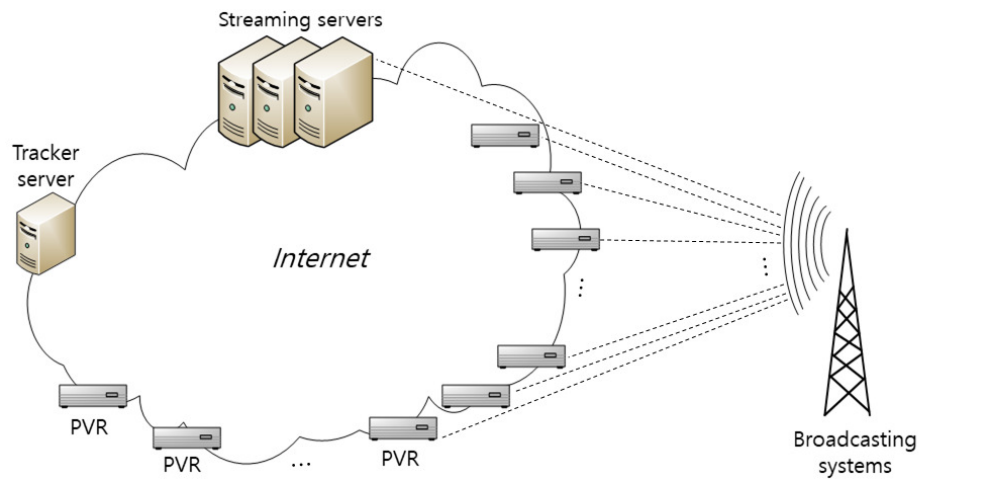
Figure 2. Overall system architecture for P2P time-shifted live streaming among